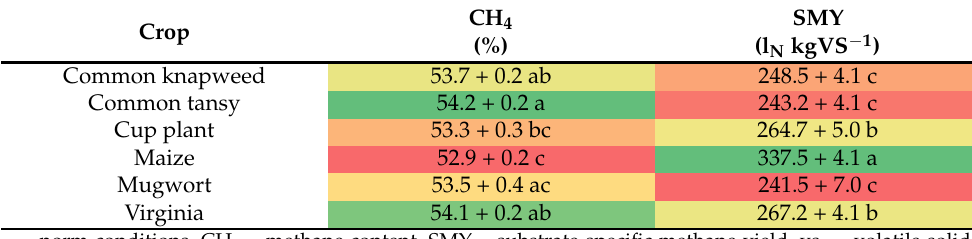
Table 4. Methane content and substrate-specific methane yield of the crops (sorted alphabetically). Additionally, the standard error is provided. The color scaling indicates per parameter the meaning of the value for the use of biomass as biogas substrate from good (dark green) to bad (deep red). CH 4 Crop (%)